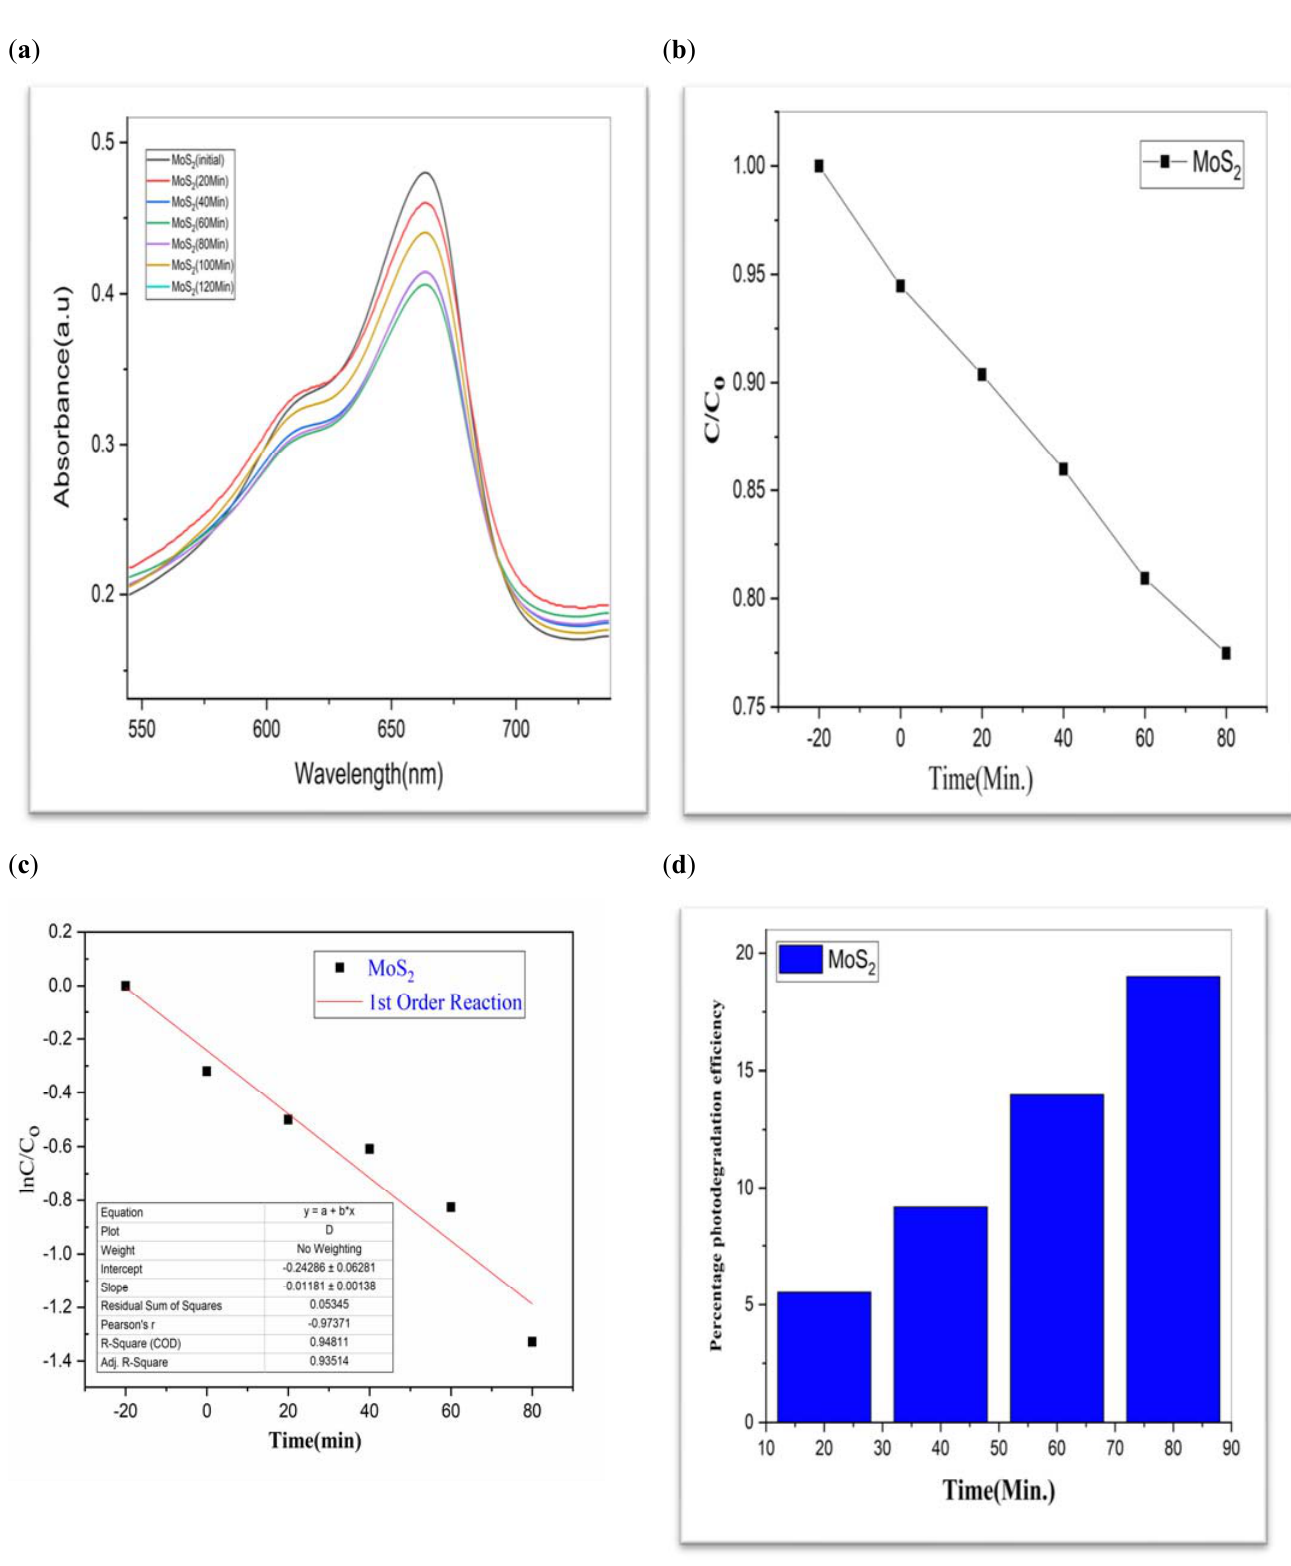
Figure 6. MoS 2 ( a ) graphical representation of degradation of methylene blue; ( b ) C/C 0 ; ( c ) lnC/C 0 ;